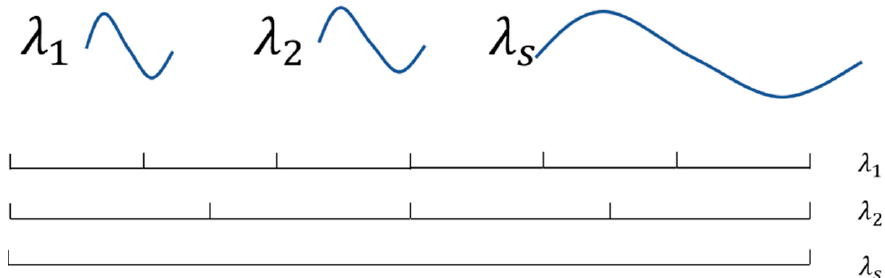
Figure 1. Synthetic wave schematic diagram.